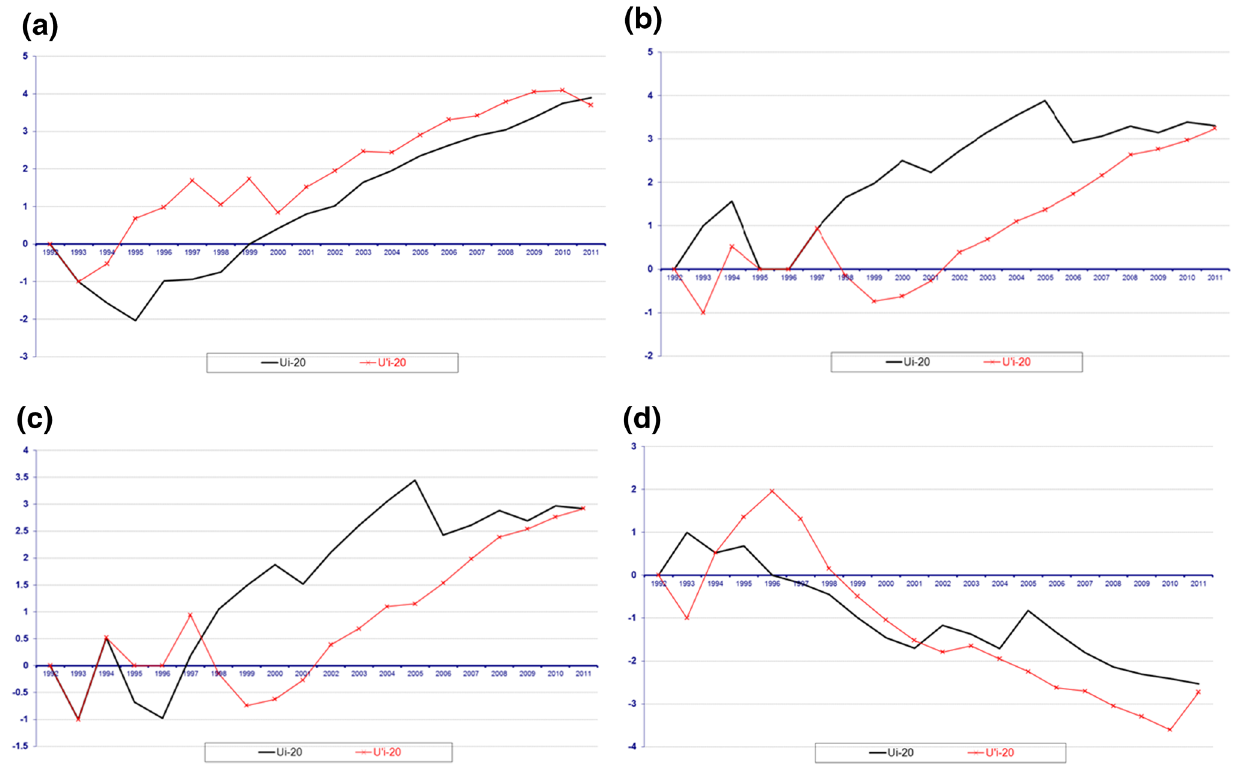
Fig. 4 Mann–Kendall plot of quality parameter for Kakareza station, a Cl, b EC, c TDS, d K